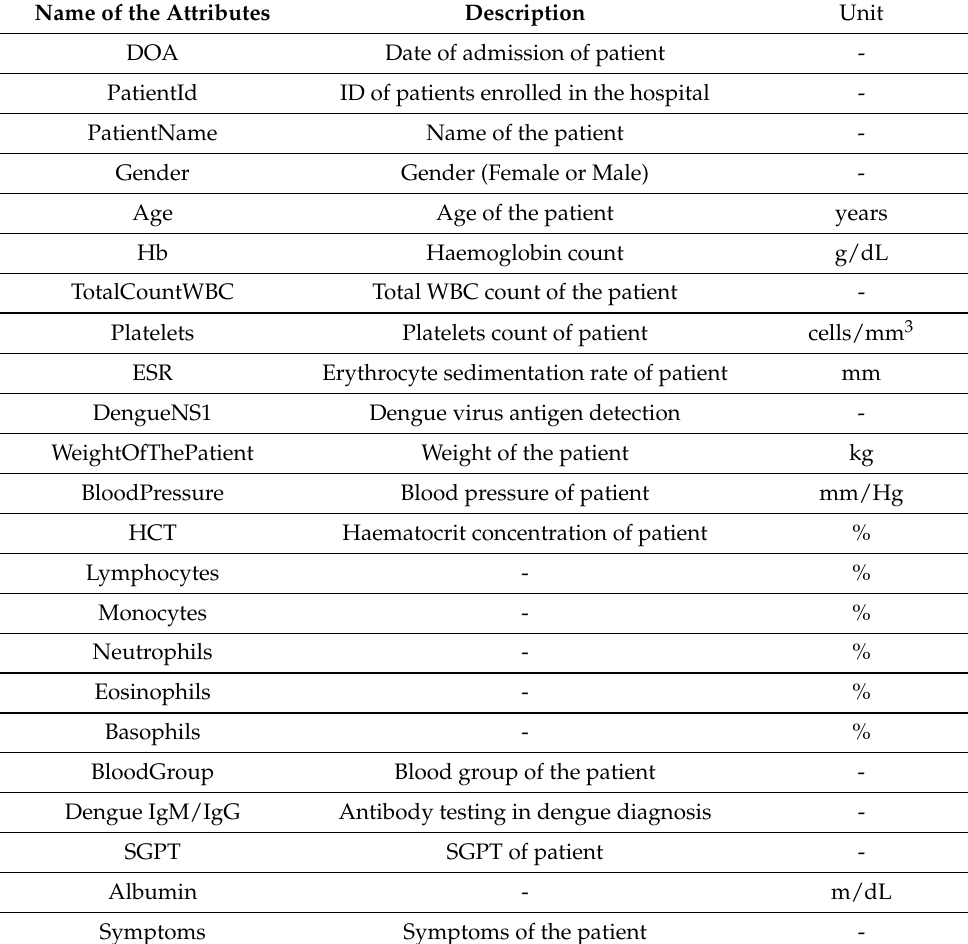
Table 2. Attributes of dataset collected from Dr. M. R. khan Shishu Hospital (Bangladesh). Name of the